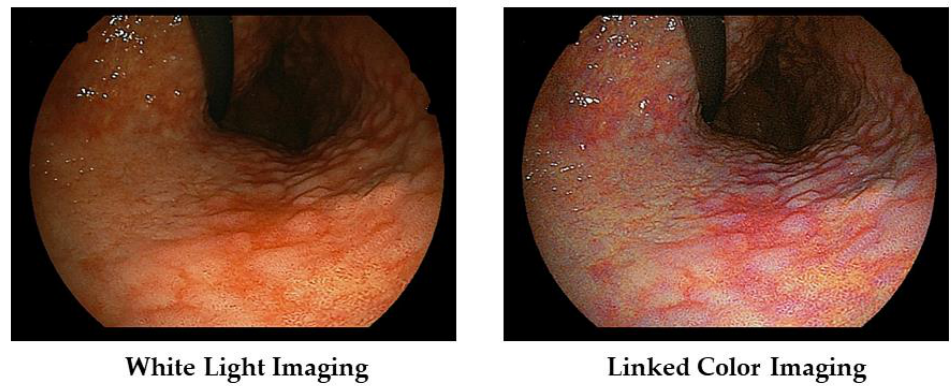
Figure 4. Typical images of atrophic gastritis (so called map-like redness) in a patient with post H. pylori eradication therapy.